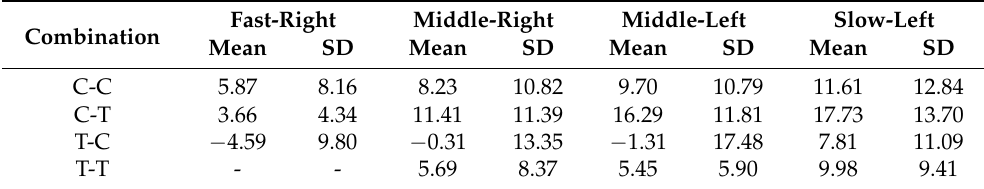
Table A2. The mean and standard deviation of ∆ V of m and n1.